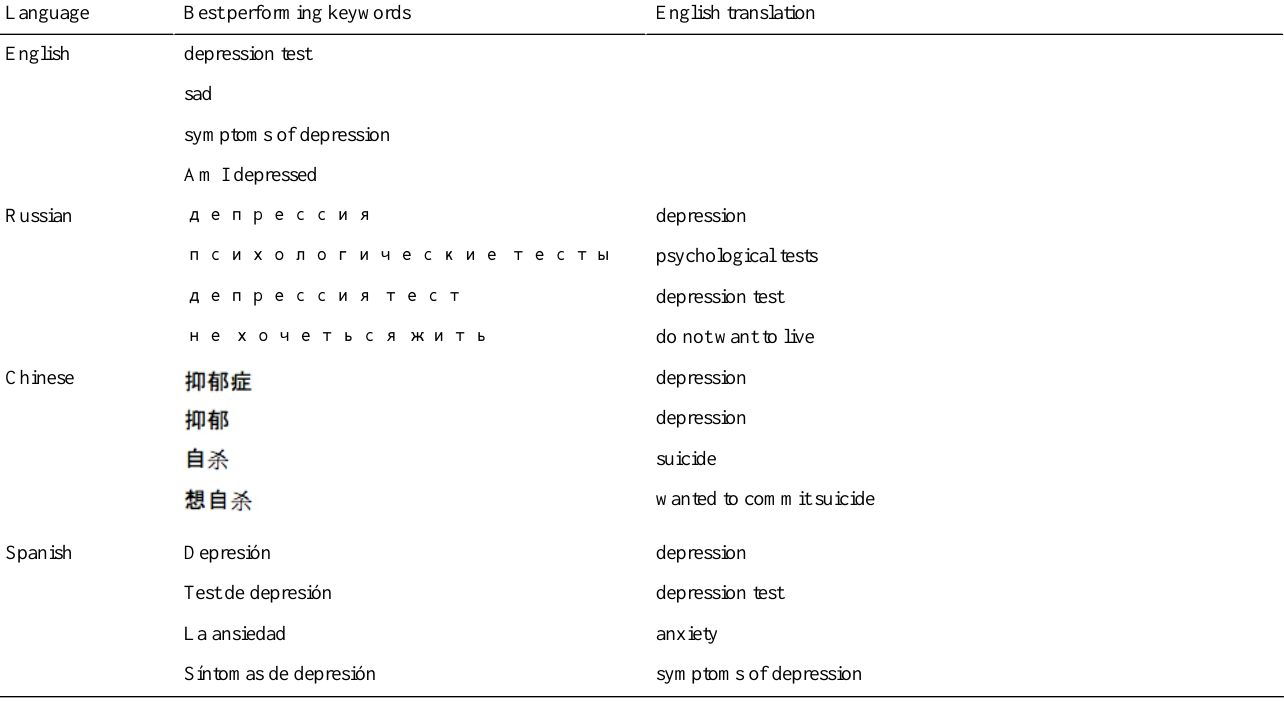
Table 2. Best performing keywords.